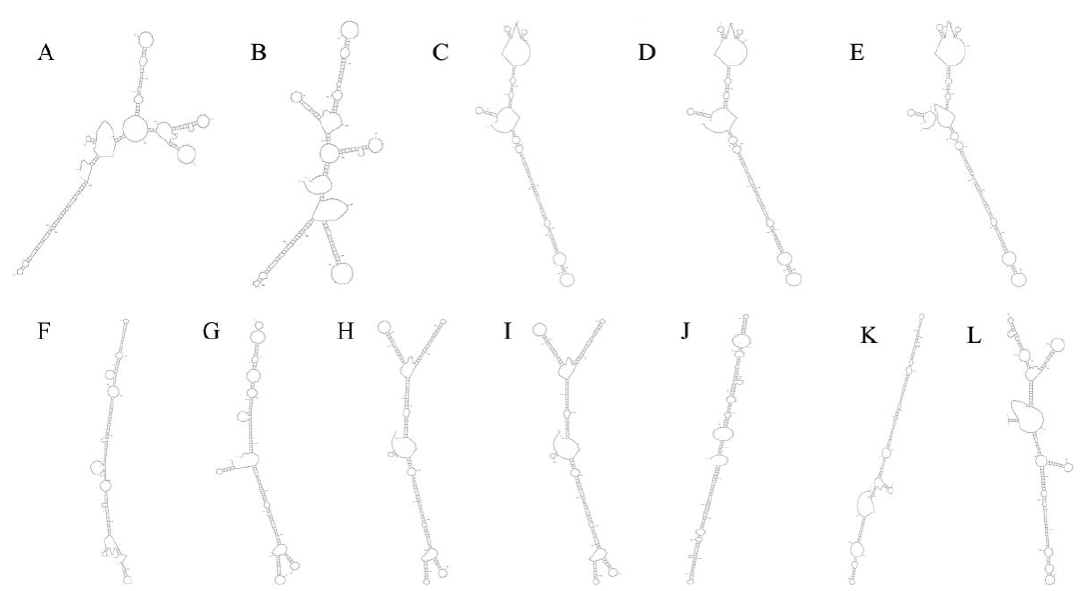
Figure 2. Stem-loop structures of twelve pre-miR166s in C. sinensis . ( A – L ) correspond to csn-MIR166 Scaffold364-1, 364-2,1344-1, 1344-2, 1344-3, 1761-1, 1761-2, 1761-3, 1761-4, 2148-1, 2148-2, and 2918.